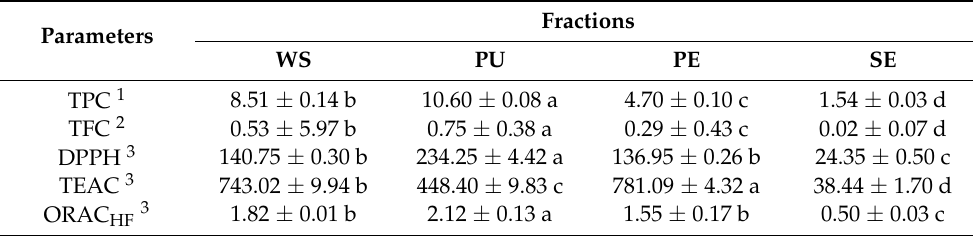
Table 4. Content of total flavonoids, content of total phenolic compounds and antioxidant capacity of the buritirana fruit